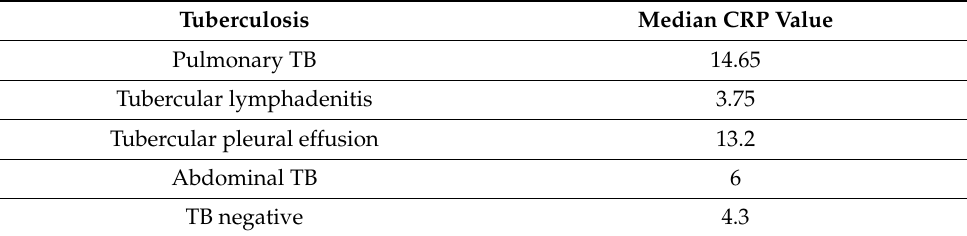
Table 4. Median C-Reactive protein values for different types of TB.